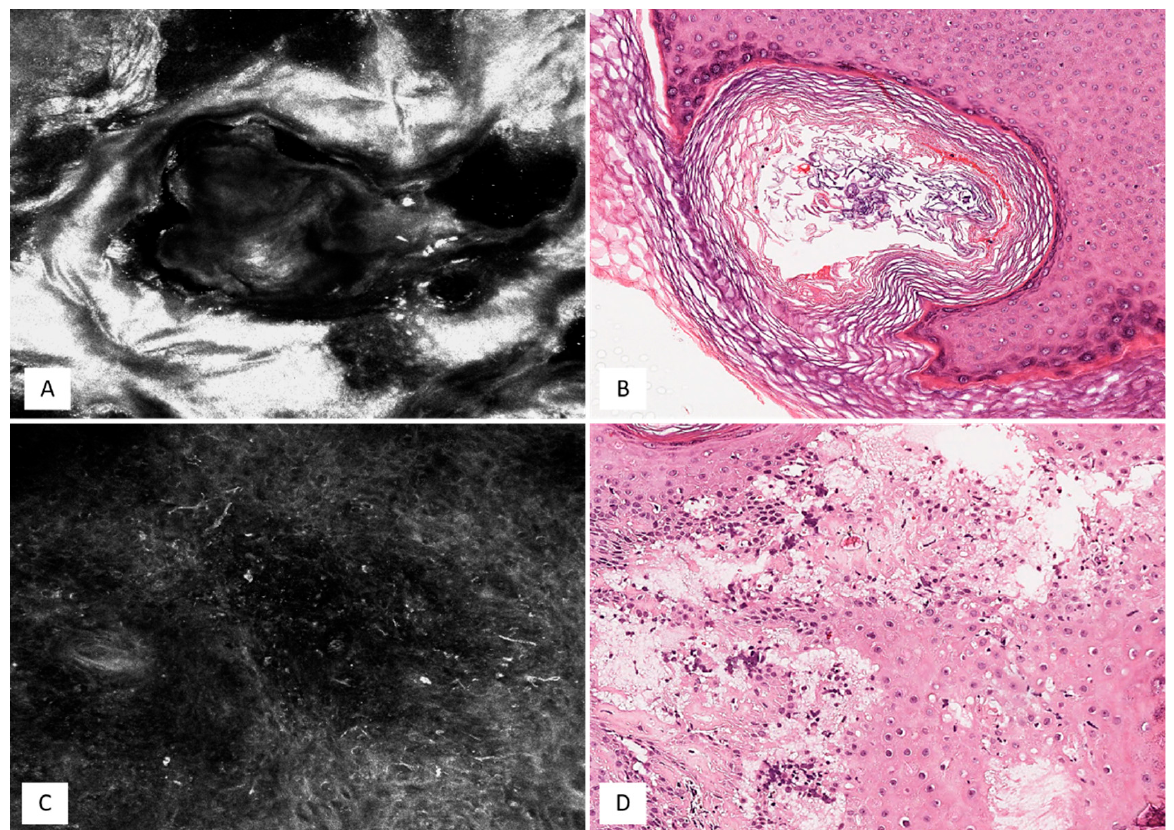
Figure 2. Stratum Corneum. ( A ) RCM shows roundish areas filled with highly refractive material. ( B ) HHSs exhibit dilated follicles with infundibular hyperkeratosis (follicular plugging) (hematoxylin and eosin: original magnification 200×). Dermo-epidermal Junction. ( C ) Several small polygonal/round bright cells and some dendritic cells with partial disappearance of the dermal papillae are encountered on RCM. ( D ) Horizontal histopathology at the same level exhibits vacuolar degeneration of the basal layer with partial disappearance of dermal papillae and mild inflammatory infiltrate (hematoxylin and eosin: original magnification 100×).